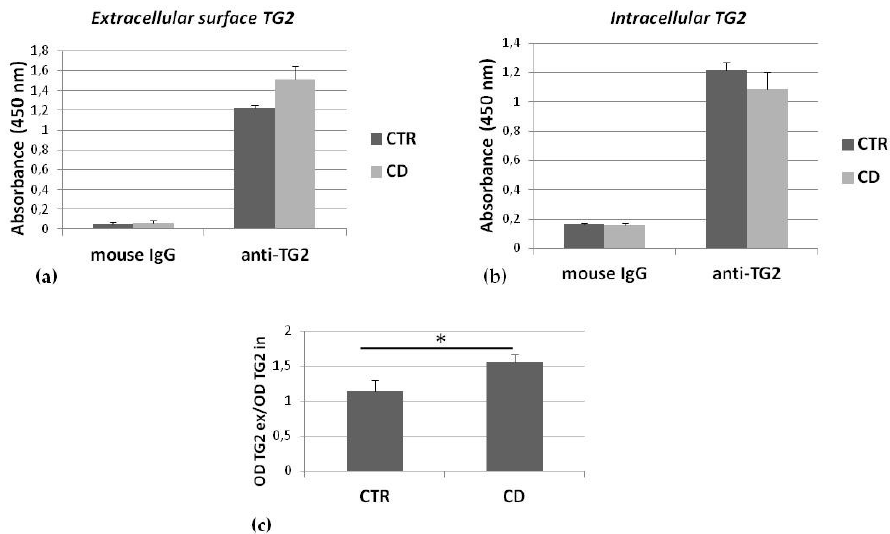
Figure 3. Relative amount of TG2 associated with the extracellular membrane surface. Absorbances relative to detection of TG2 on cell surface ( a ) and of intracellular TG2 ( b ) of one representative control sample and one representative CD sample. In both ( a ) and ( b ), absorbances relative to non-specific mouse IgG, used as negative control, are also shown. Each determination is made in triplicate. ( c ) Graphical representation of mean values (and standard deviations) of ratios between absorbance (OD) relative to surface TG2 (TG2 ex ) and to intracellular TG2 (TG2 in ), measured in corresponding wells, referred to analysis performed on three control and three CD cultures. Asterisk (*) indicates that p is < 0.05.